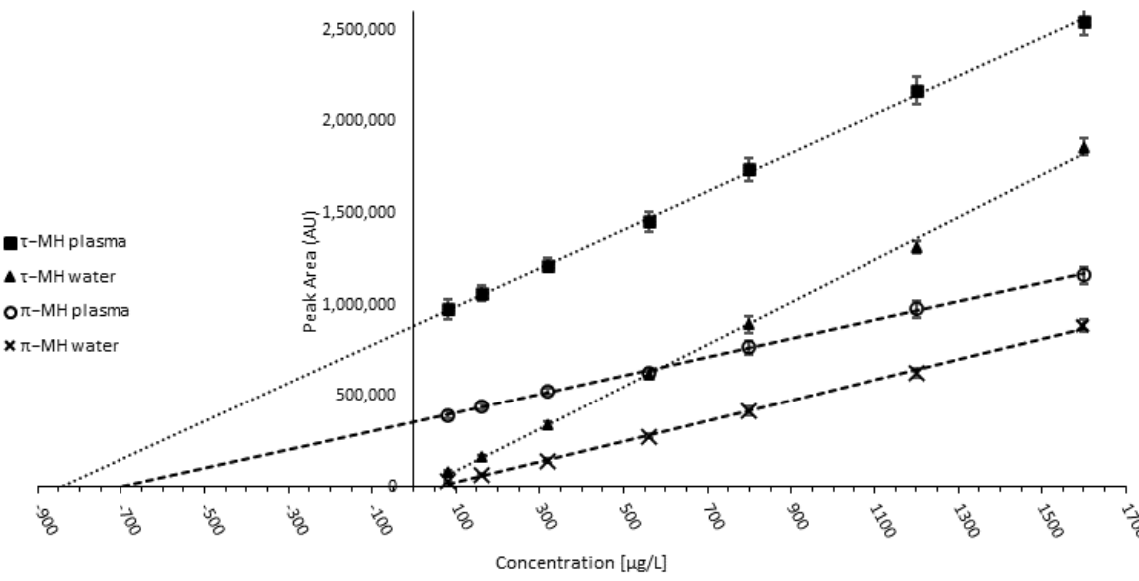
Figure 4. Standard addition and surrogate matrix calibration curves for τ - and π -methylhistidine at the selected concentrations. Extrapolation of the standard addition curve indicates the endogenous value of τ - and π -MH in the pooled sample.